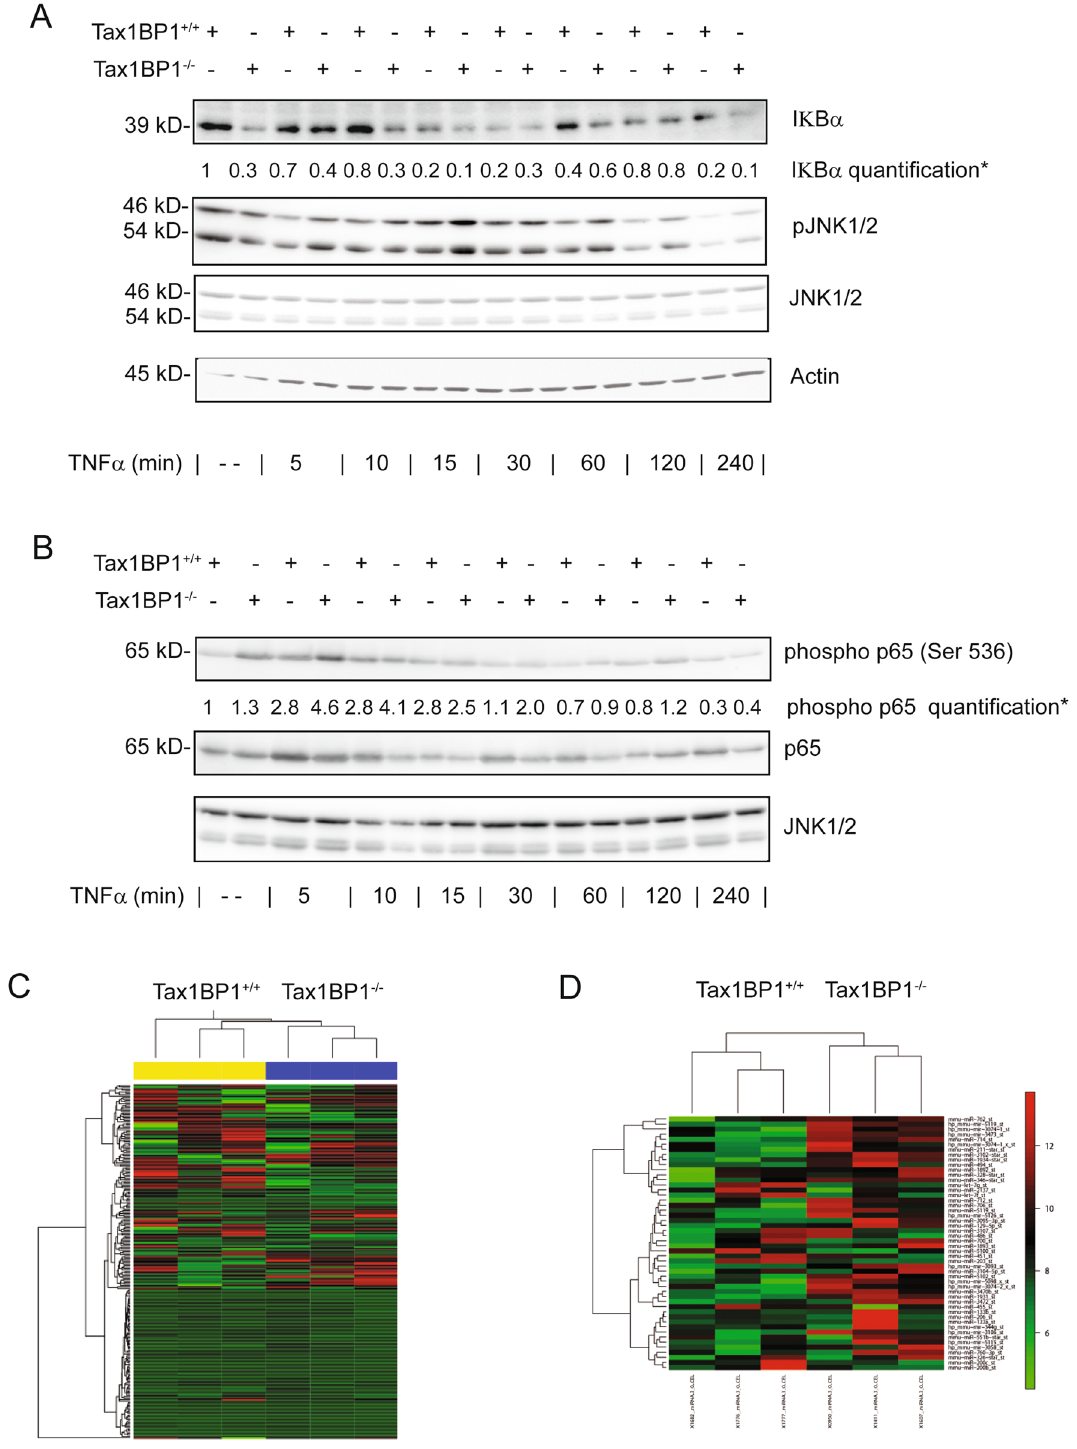
Figure 3. Activation of NFκB and JNK pathways in hepatocytes and differentially regulated mRNA and miRNA in Tax1BP1 +/+ and Tax1BP1 −/− mice. Livers of mice were extracted after terminal perfusion and hepatocytes were isolated. Hepatocytes were stimulated with TNFα for the indicated time points and Western Blotting was performed with the indicated antibodies. Representative results of three independent isolations of primary cells are shown. Densitometry was performed for three independent blots and mean values are shown (*) ( A , B ). Livers form three Tax1BP1 +/+ and three Tax1BP1 −/− mice were excised, RNA was extracted and microarray analyses were performed determining mRNA ( C ) and miRNA ( D )